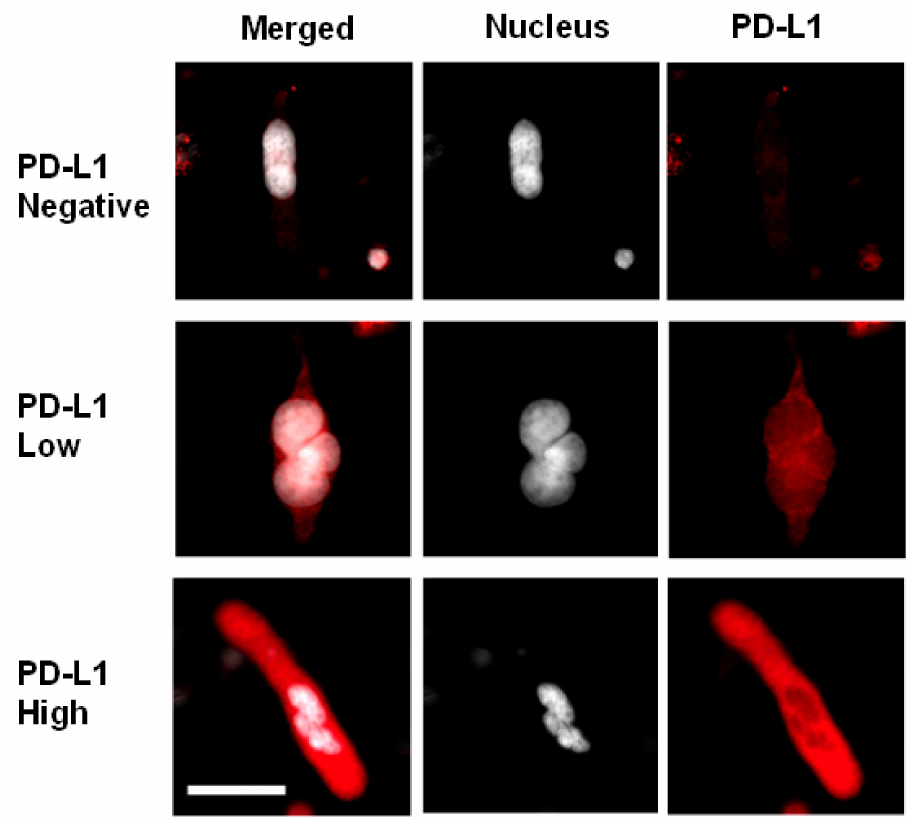
Figure 12. PD-L1 expression is determined in CAMLs by the intensity of PD-L1 staining by micro- scope imaging: PD-L1 (red), Nucleus (white). The cytokeratins and CD45 channels are not displayed. The scoring is based on the average value of PD-L1 staining in the CAML. The white color is used for the nucleus to make the merged image of PD-L1 negative and low-expression cells more visible. The scale bar is 50 µ